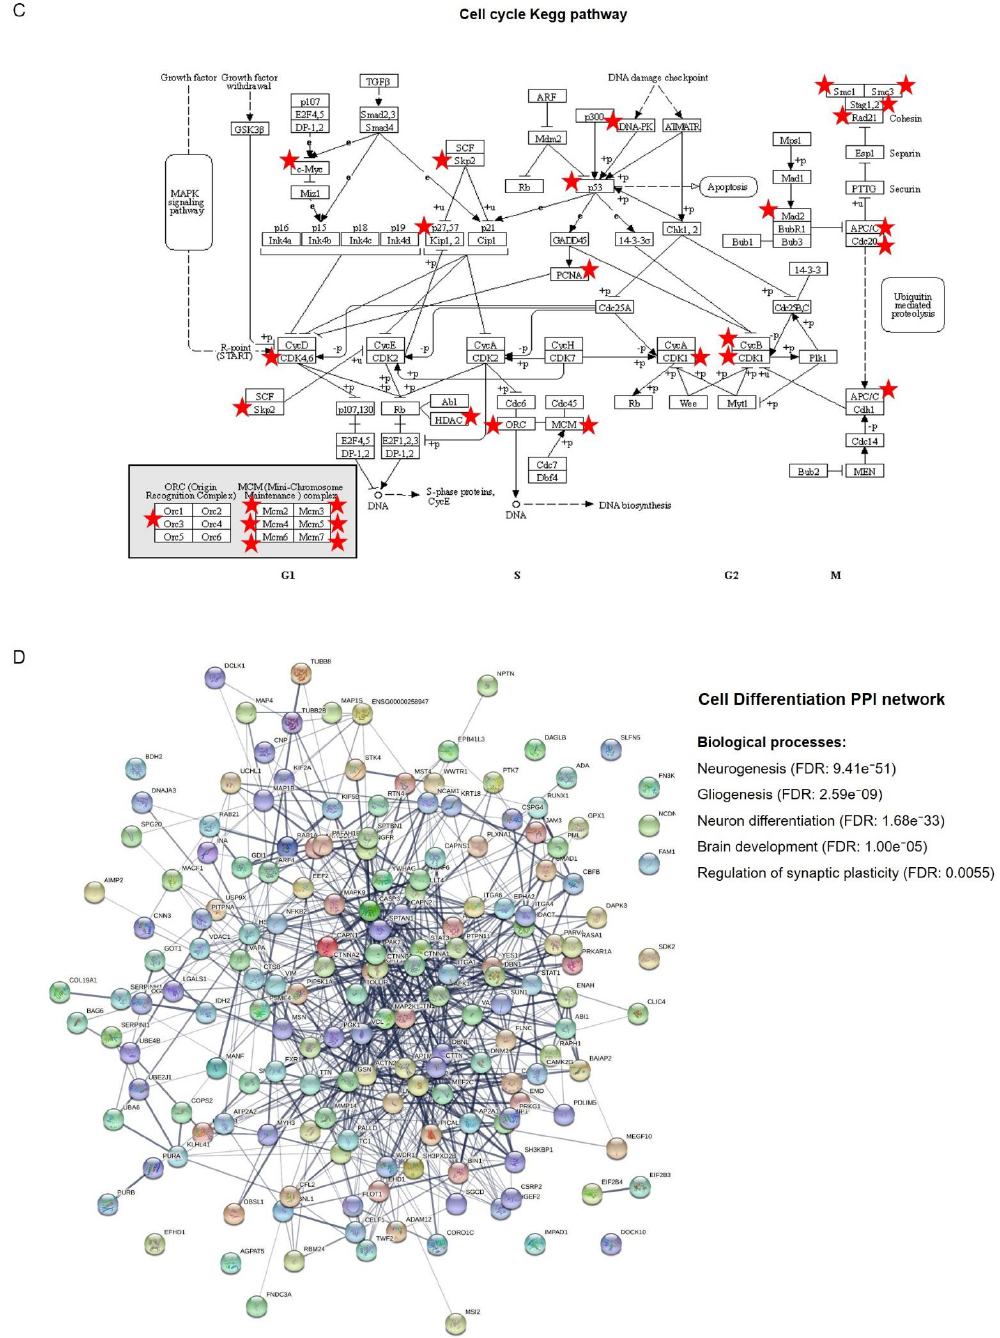
Figure 2. Networks modulated after PMA treatment. ( A ) Heat map based on Euclidean distance showing a significant separation between the CTR and the PMA treated conditions. Each row of the heat map represents a protein, and each column represents an independent sample. Two main clusters were identified from the hierarchical clustering, and their pattern is reported. ( B ) Heat map based on Euclidean distance showing proteome modifications occurring during MO3.13 treatment with PMA for 48 h and 96 h. The profile plot of the minichromosome maintenance complex proteins (MCM2-MCM7) is reported, and the time-dependent downregulated proteomic response to the treatment was significant at 96 h. Western blot analysis of PKC substrates activation after 48 h and 96 h of PMA treatment is reported. Blot stained for total protein with Ponceau S is reported. ( C ) Cell cycle KEGG pathway is visualized. The red stars indicate differen- tially expressed proteins involved in the pathway and identified by MS/MS, or Western blotting, after PMA treatment. ( D ) Protein–protein interaction (PPI) network analysis performed on the 175 proteins related to the statistically enriched biological process of “cell differentiation” (GO term) (FDR 0.00041), according to STRING